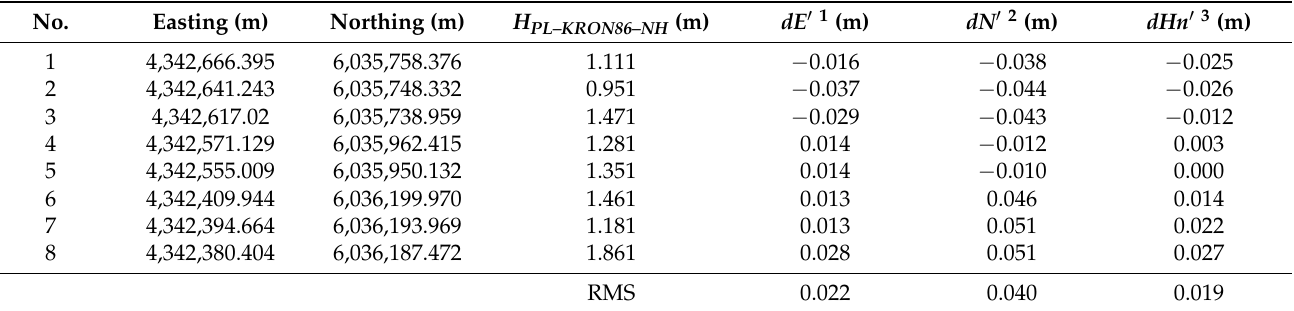
Table 7. Measurement point coordinates determined by the method of P.S. D ˛abrowski et al., and their differences in relation to the reference point coordinates.